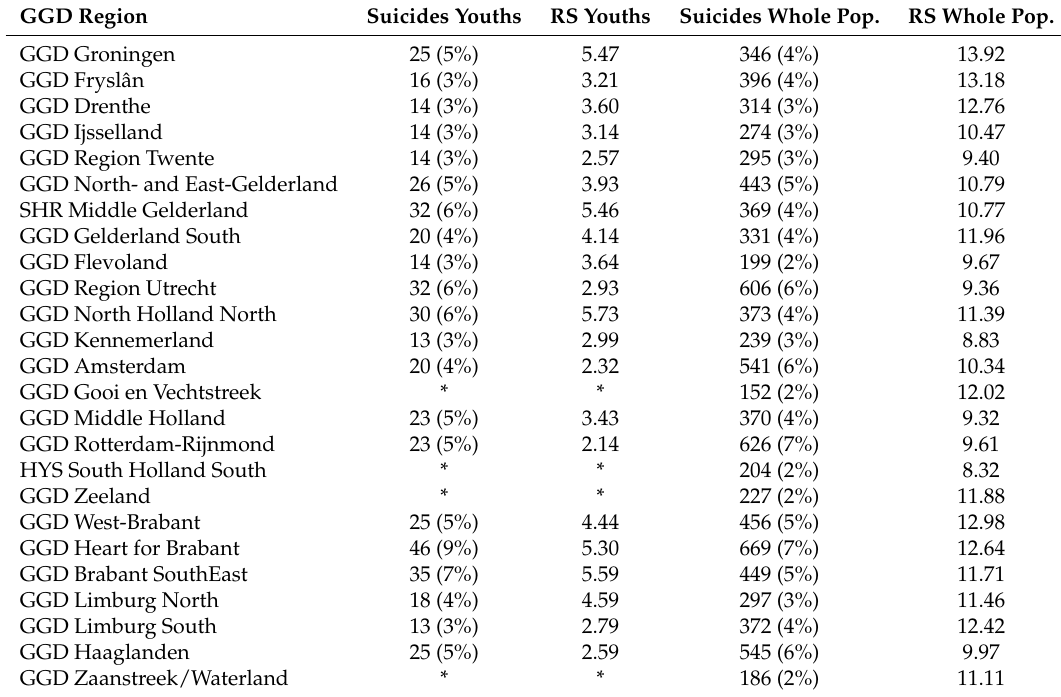
Table 5. Number of suicide victims under 23 and among the population as a whole in the period 2013–2017 by Municipal Health Service (GGD) region (RS = Relative Suicide rate per 100,000 per year, SHR = Security and Health Region, HYS = Health and Youth Service) (percentage of total in Netherlands in brackets). Suicides Whole